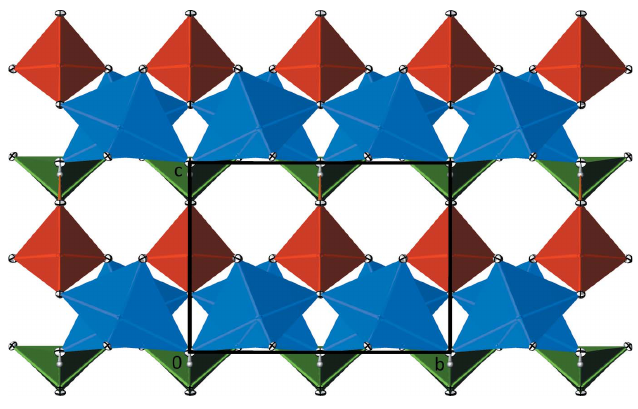
Figure 5 Channels in the structure of Zn 2 (HTeO 3 )(AsO 4 ) running parallel to [100]. Colour codes and displacement ellipsoids are as in Fig. 3.